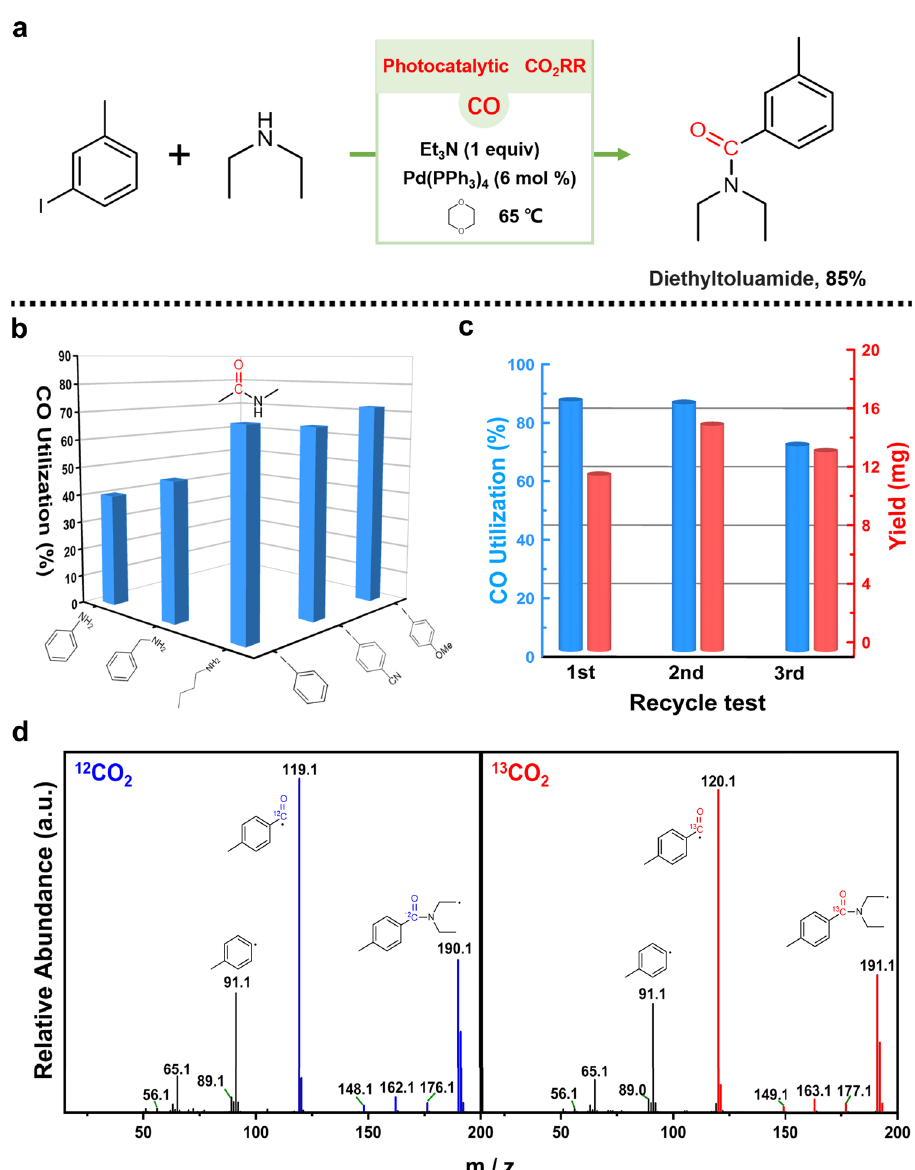
Fig. 6 DEET production by tandem catalytic reaction and substrates screening were performed to determine the optimum conditions. a Schematic illustration of the synthesis procedure of DEET via tandem reaction and actual CO utilization. b Select optimization conditions of the carbonylation reaction. c The recycle experiments of tandem reaction were conducted. d GC-MS shows the different mass charge ratios ( m / z ) when 12 CO 2 (blue) and 13 CO 2 (red) as the source of CO by the tandem reaction to synthesize DEET. Further details about high-resolution mass spectrometry are provided in Supplementary Fig.